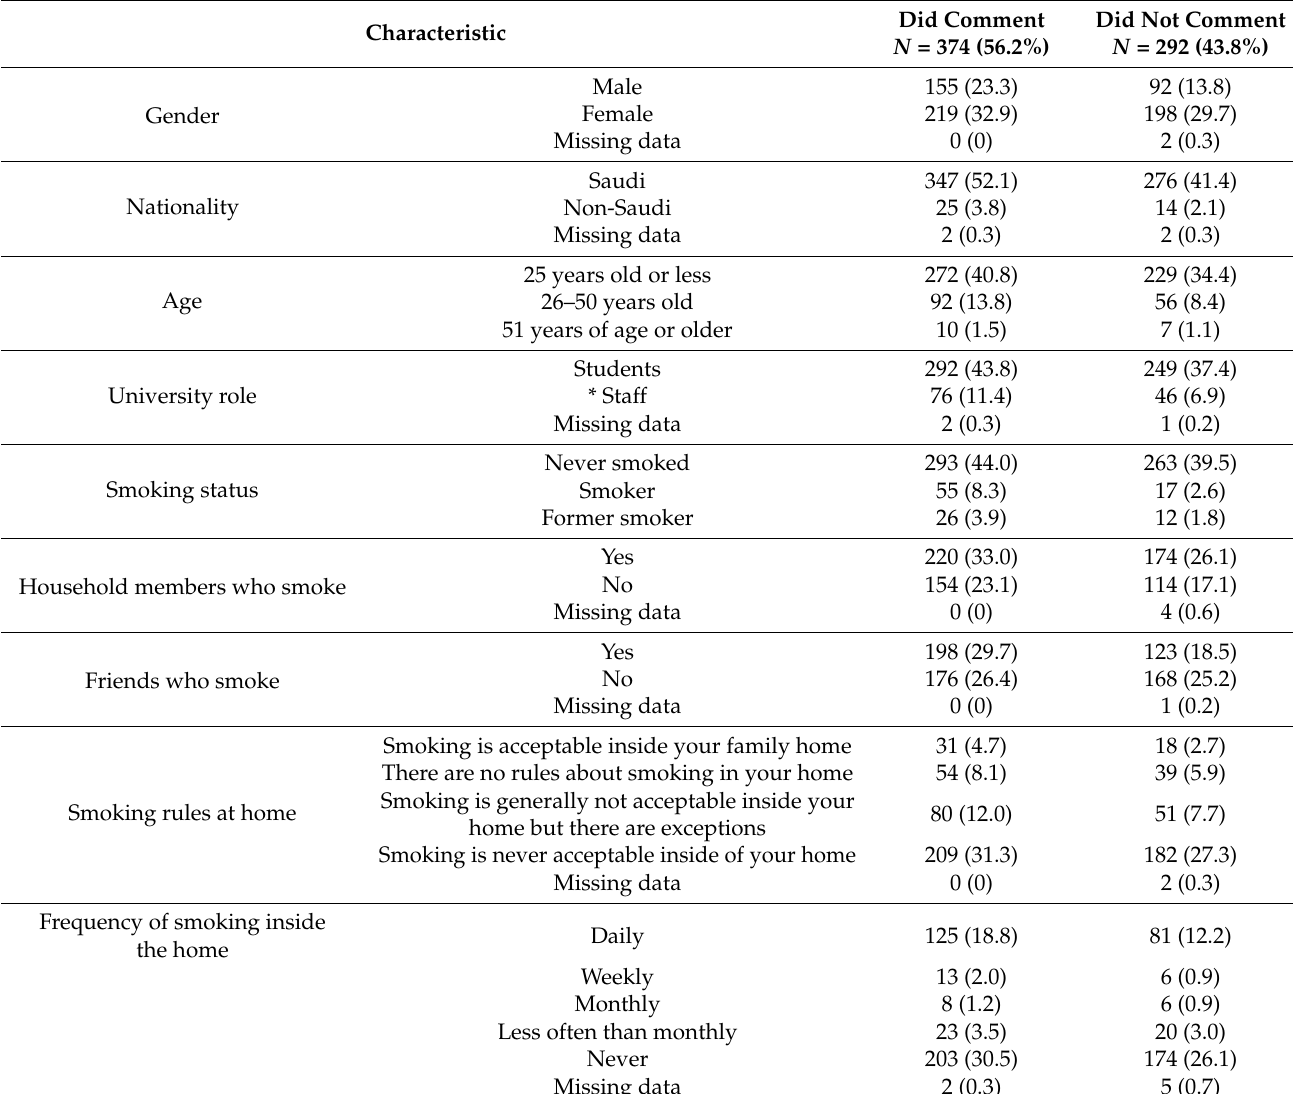
Table 1. Demographics of respondents who did and did not comment on the impact of COVID-19 on smoking ( N =